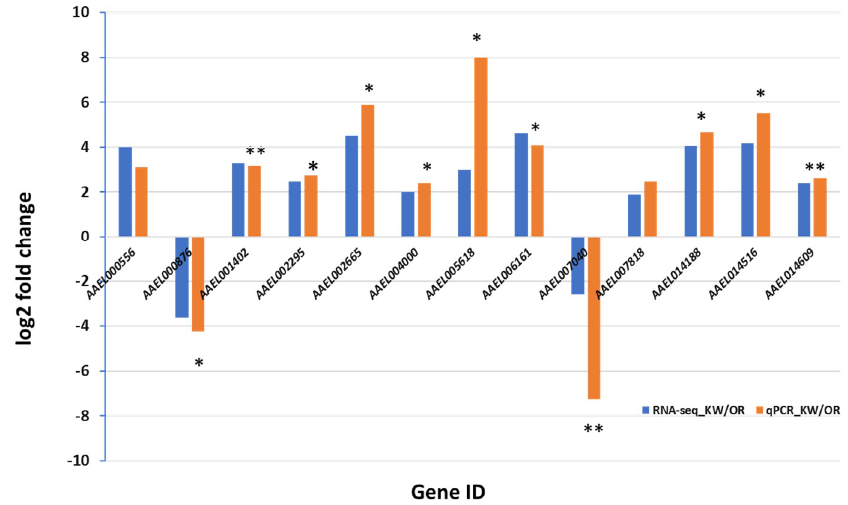
Figure 2. Validation of the expression of transcripts between the permethrin resistant (KW) and susceptible (OR) strains of Aedes aegypti by qRT-PCR. * p < 0.05. ** p < 0.01. (Control) between Two Aedes aegypti Strains, Resistant Versus Susceptible Strains Functional analysis based on Gene Ontology were conducted on the significant differentially expressed (DE) transcripts between the permethrin resistant and susceptible strains of Ae. aegypti . Comparison of the transcriptome profiles showed a relatively low number of DE transcripts 12 h after blood-feeding. There were 90 DE transcripts at 12 h post blood-feeding (p-adj ≤ 0.01), of which 35 were upregulated and 55 were downregulated (Figures 3A and S1A). The largest proportion of total number of DE genes (38.9%) had unknown functions (Figures 3A and S1A). Other DE transcripts mainly belonged to the functional categories of Binding (23.3%), Catalytic activity (14.4%), Cellular process (12.2%), Response to stimulus (5.6%), and Transporter activity (4.4%). All other categories